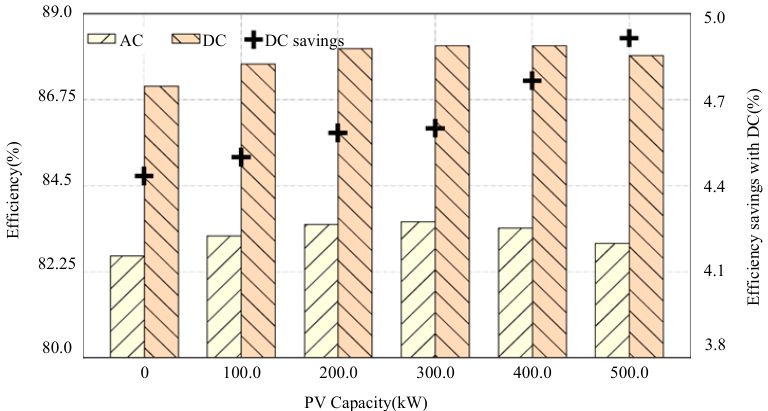
Figure 8. Efficiency trend with installed capacity of distributed PV.